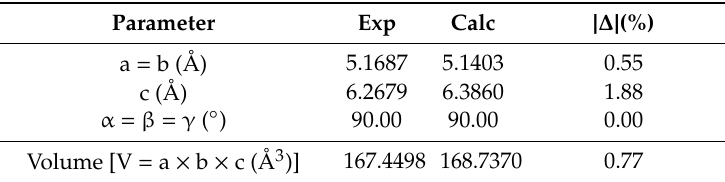
Figure 1. Crystal structure of LiAlO 2 (space group P4 1 2 1 2). Table 1. Calculated structural parameters for LiAlO 2 (space group P4 1 2 1 2) as compared to the experimental determinations [35].